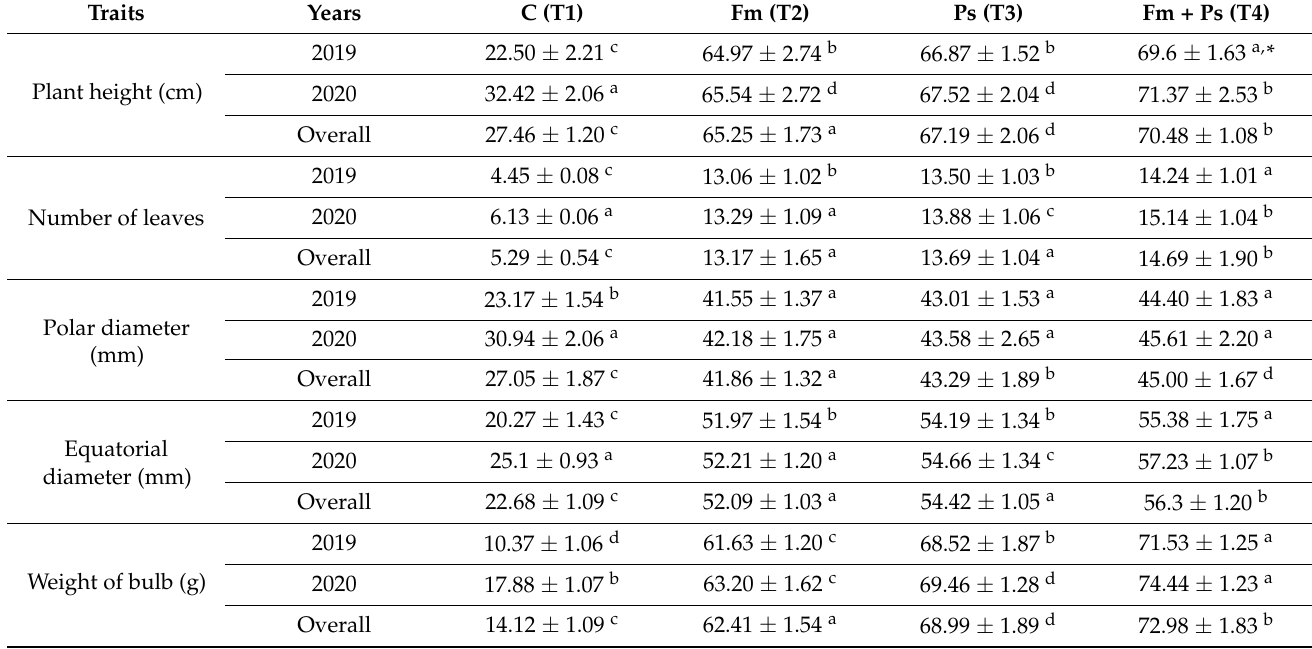
Table 1. Effects of Funneliformis mosseae and potassium silicate on morphological traits and mineral content of onion under water